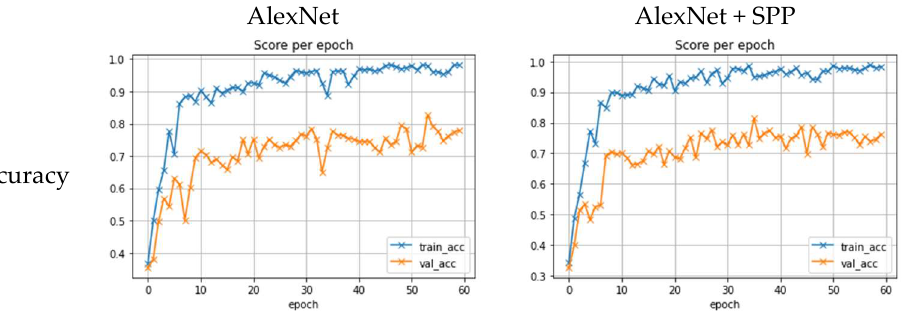
Figure 10. Performance comparison analysis between AlexNet and AlexNet + SPP.